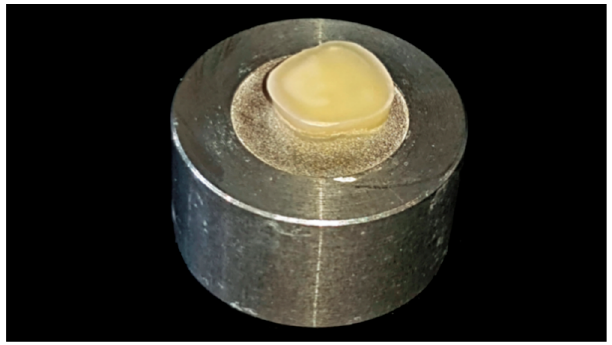
Figure 2. Occlusal part of tooth cut off, resulting in a horizontally parallel plane.